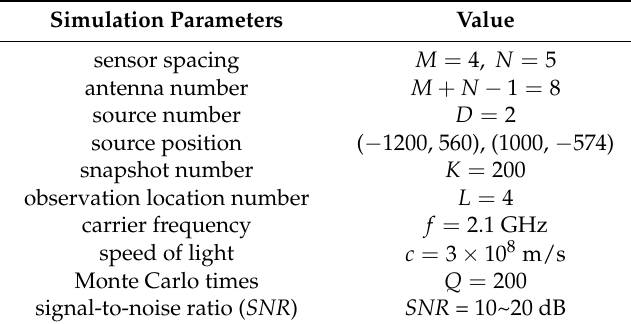
Table 1. Simulation conditions for the experiments.